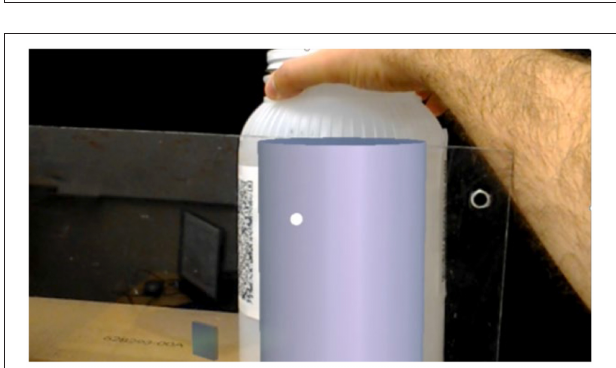
FIGURE 16 | The tracking algorithm used to follow the canister is robust to occlusion of the QR code.